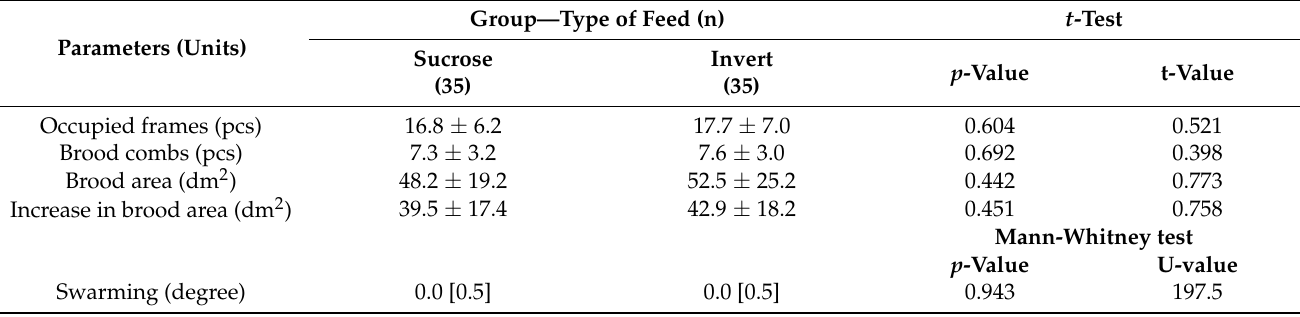
Table 4. Colony growth in the late spring within blooming of cherry-trees characterized by five monitored parameters describing the amount of adults or brood and tendency to swarm (on an ordinal scale). Differences were statistically tested (df = 68) by t -test in case of data on a ratio scale and Mann–Whitney test for data on an ordinal scale. No difference was statistically significant in dependence of the type of